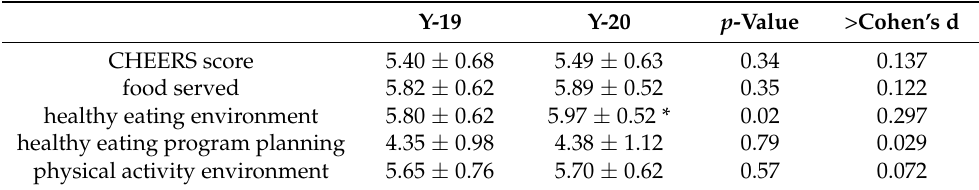
Table 3. CHEERS and subscale scores for ECEC environments before and during the COVID-19 pandemic.